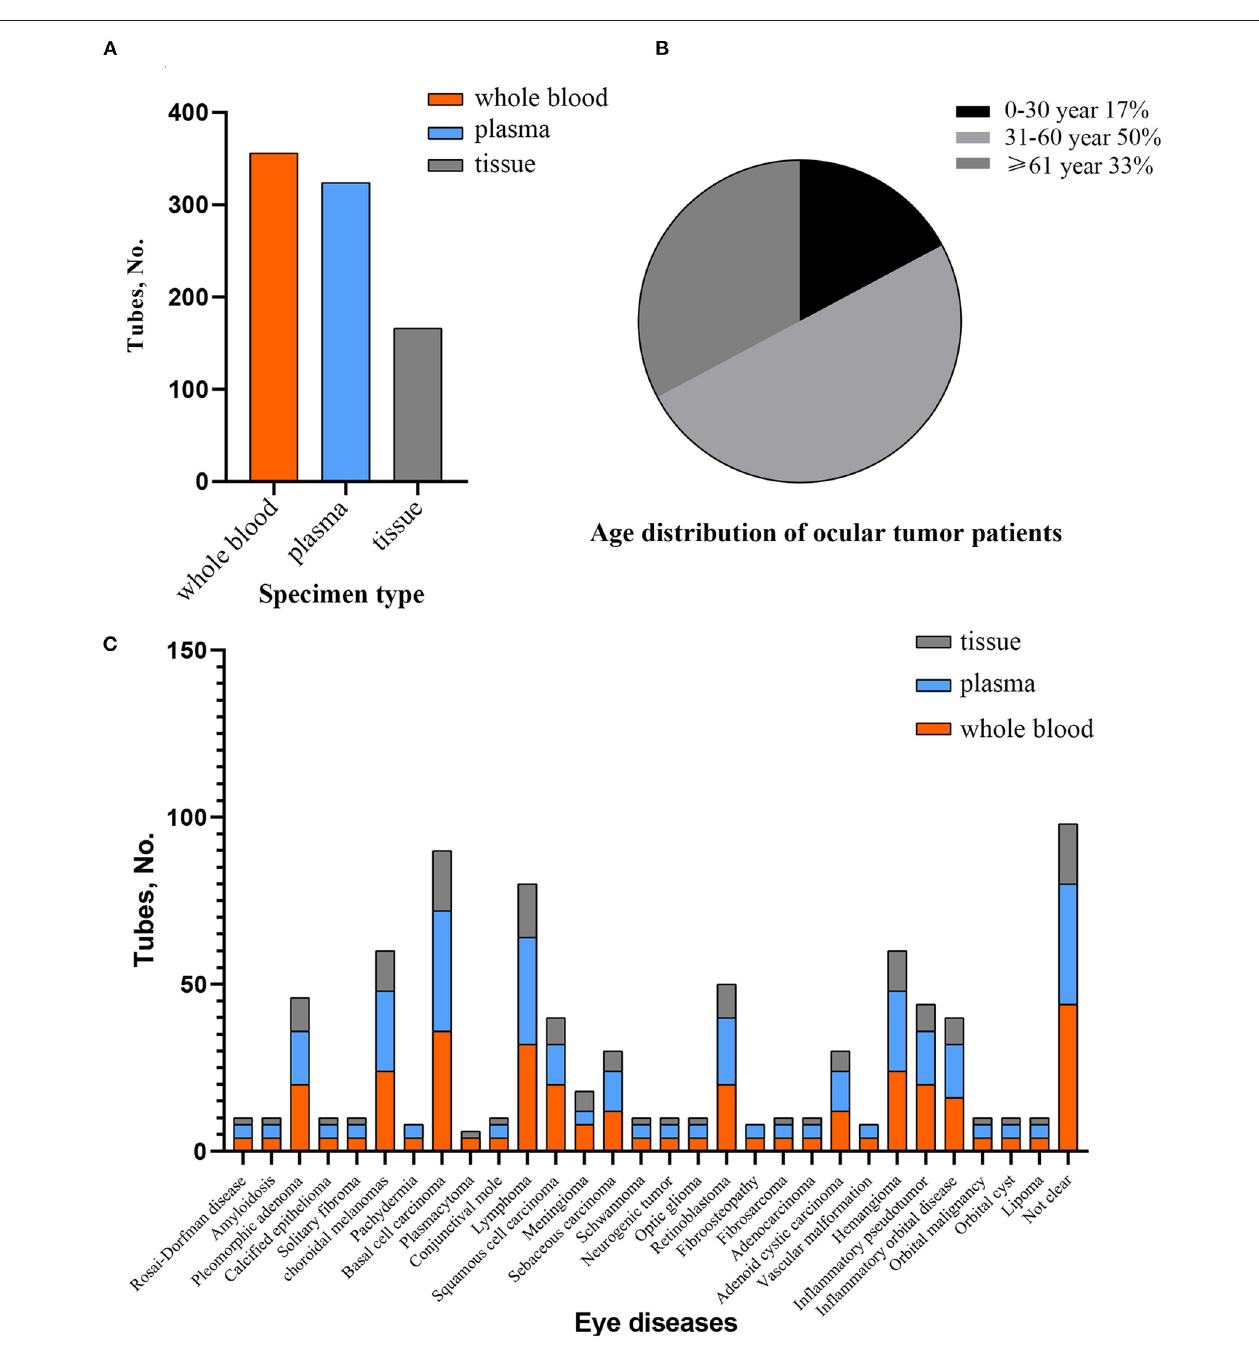
FIGURE 2 | The overview of specimen collection. (A) Number of samples according to different types in preservation. (B) Age distribution of eye tumor cases. (C) Specimen’s condition concerning various kinds of suspected or diagnosed ocular tumor stored in biobank.